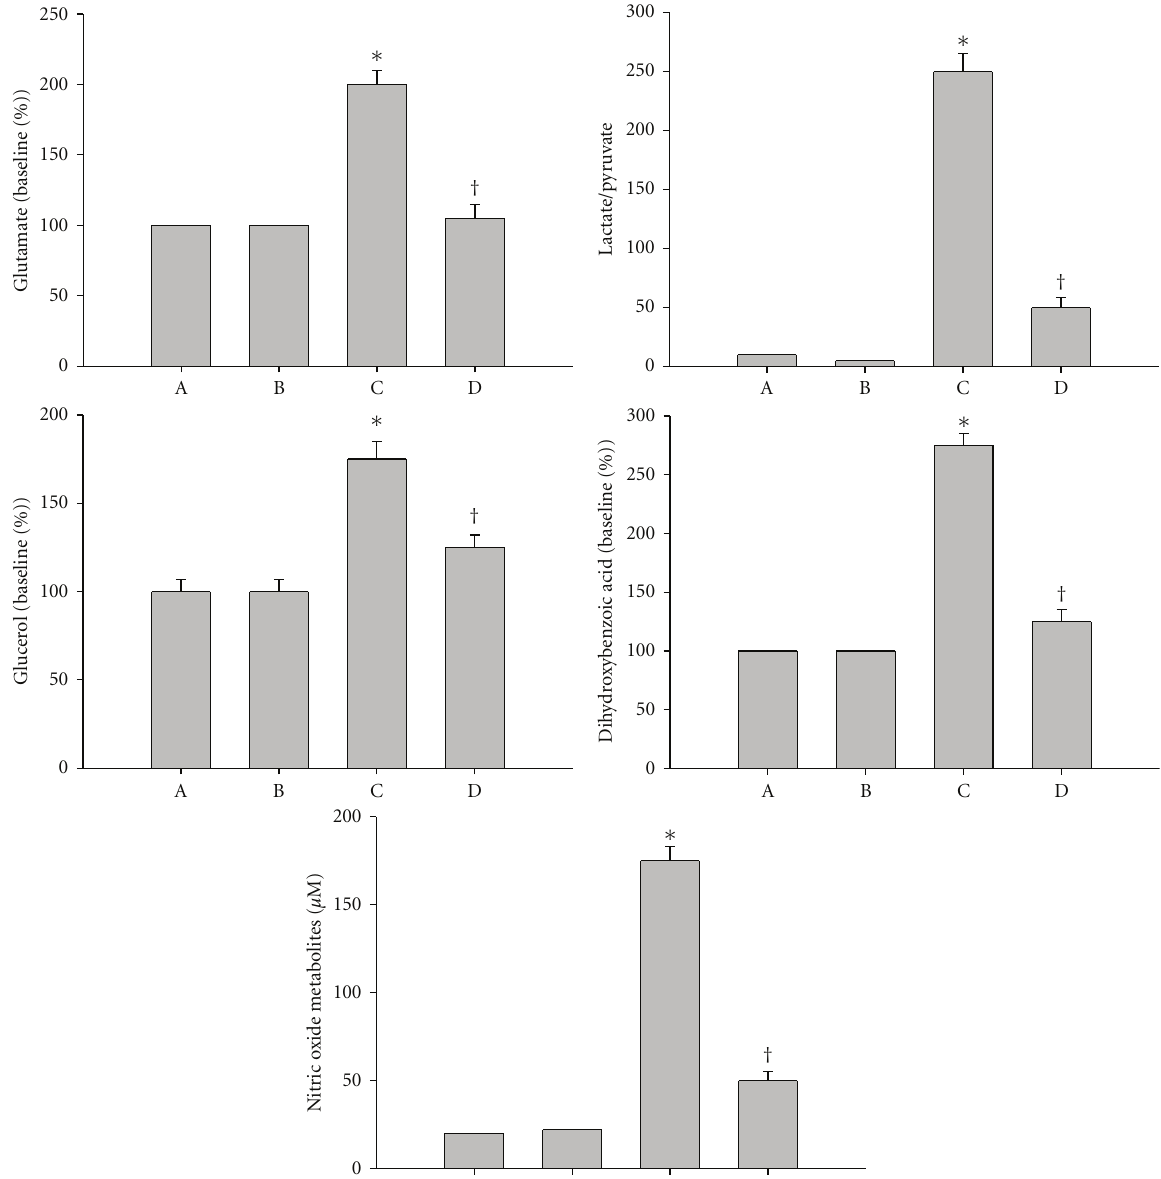
Figure 2: E ff ects of heat exposure (42 . 4 ◦ C for 1 hour) on extracellular levels of glutamate, lactate-to-pyruvate ratio, glycerol, dihydroxybenzoic acid, and nitric oxide in the hypothalamus of normothermic mice received normobaric air (A), normothermic mice received hyperbaric oxygen (B), heatstroke mice received normobaric air (C), and heatstroke mice received hyperbaric oxygen (D). Bars are mean ± SE of eight mice per group. Samples were obtained at 4 hours after the termination of 1-hour heat exposure or the equivalent time for the normothermic controls. ∗ P < . 01 compared with corresponding control values in group (A). † P < . 01 compared with corresponding values in group